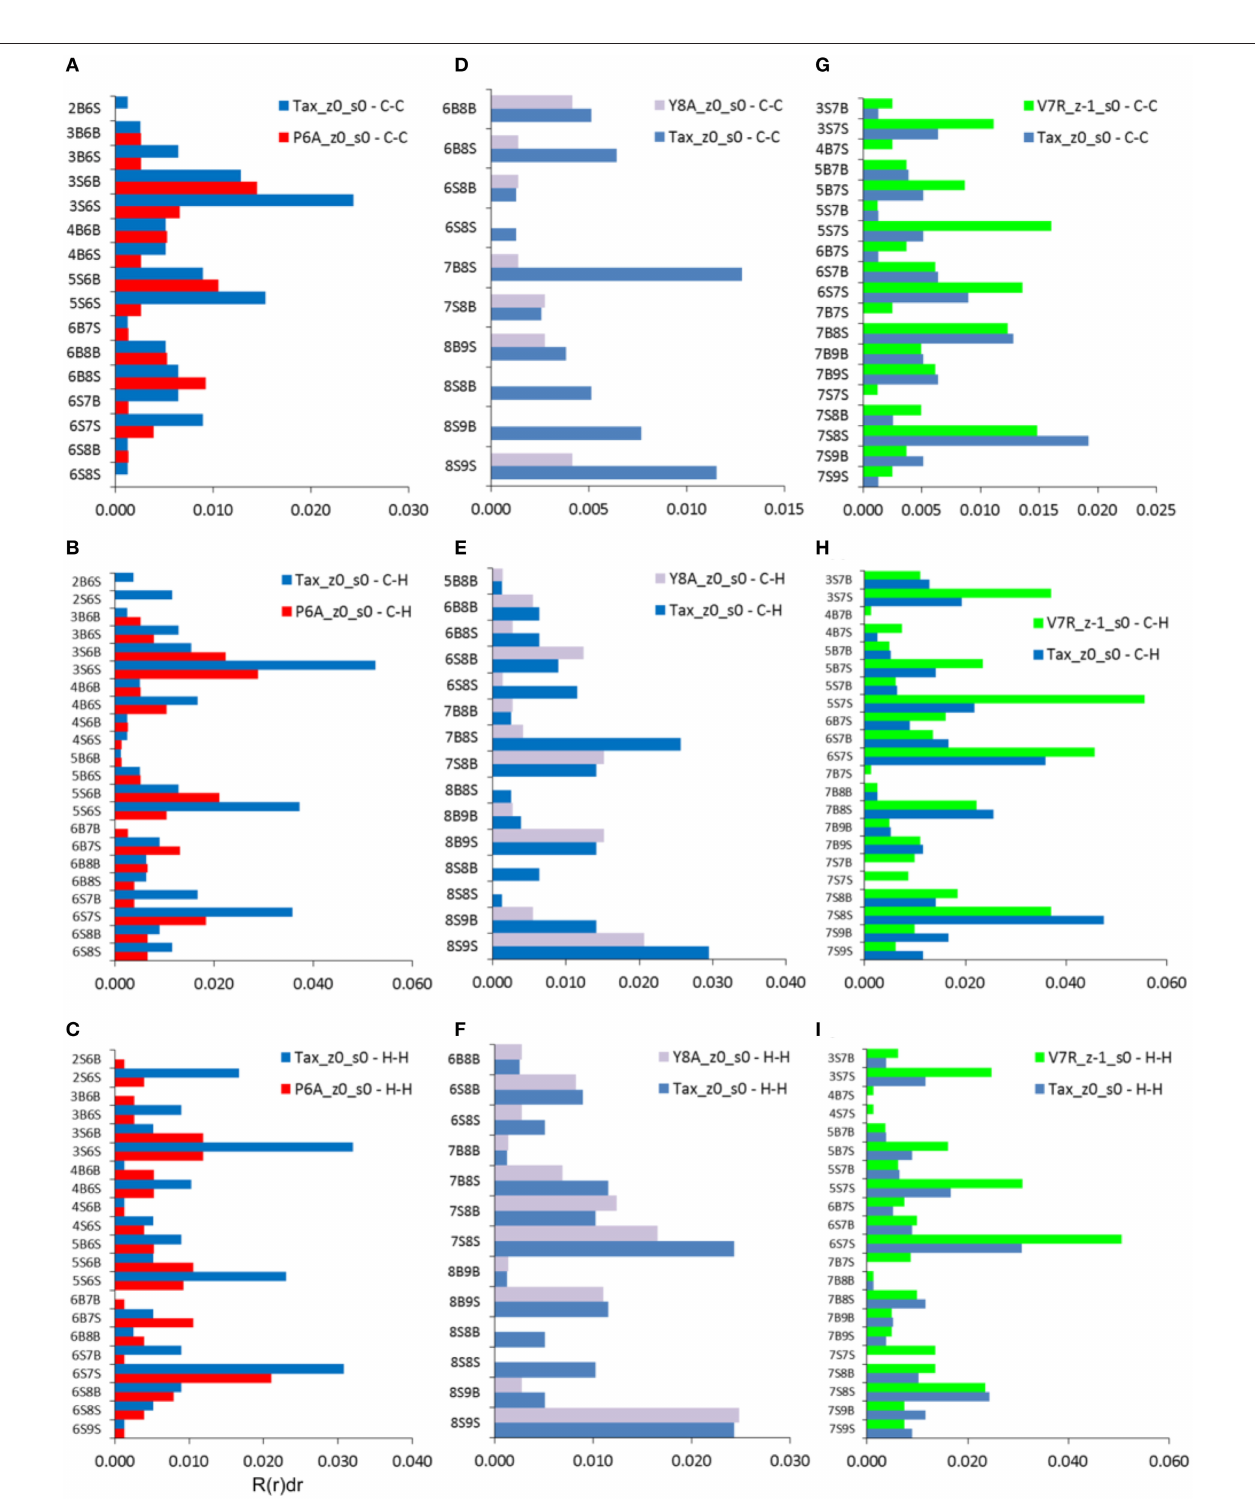
FIGURE 8 | Coordination, R(r)dr, per type of interaction (vertical axes) for the C-C, C-H, and H-H partials of non-polarized peptide structures. All graphs include contributions by Tax for the sake of comparison: (A–C) P6A, (D–F) Y8A, and (G–I) V7R. All data refer to interatomic distances within the range 5–7Å. Each interaction represents a group of interatomic distances and is symbolized by the number of the residue hosting each atom and a designation denoting a backbone, “B,” or side chain, “S,” atom position. For example, interaction “2B6S” denotes the coordination sum which arises from all interatomic distances between backbone atoms (“B”) on residue 2 and side chain atoms (“S”) on residue